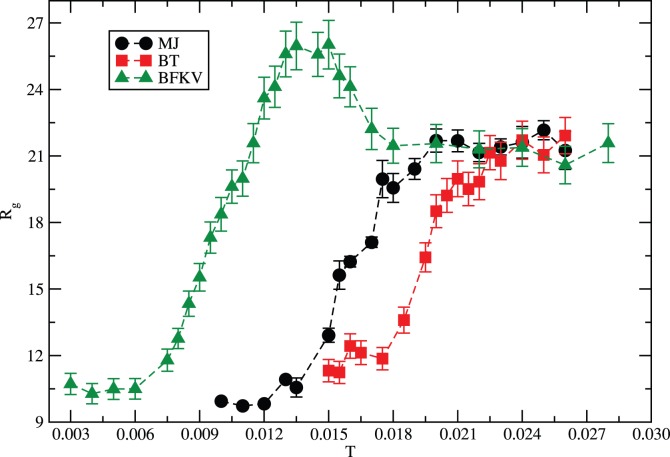
Variation of the average radius of gyration (Rg) of histone H3.1 with the temperature using MJ, BT and BFKV potentials with the same statistics as in
figure 5
.